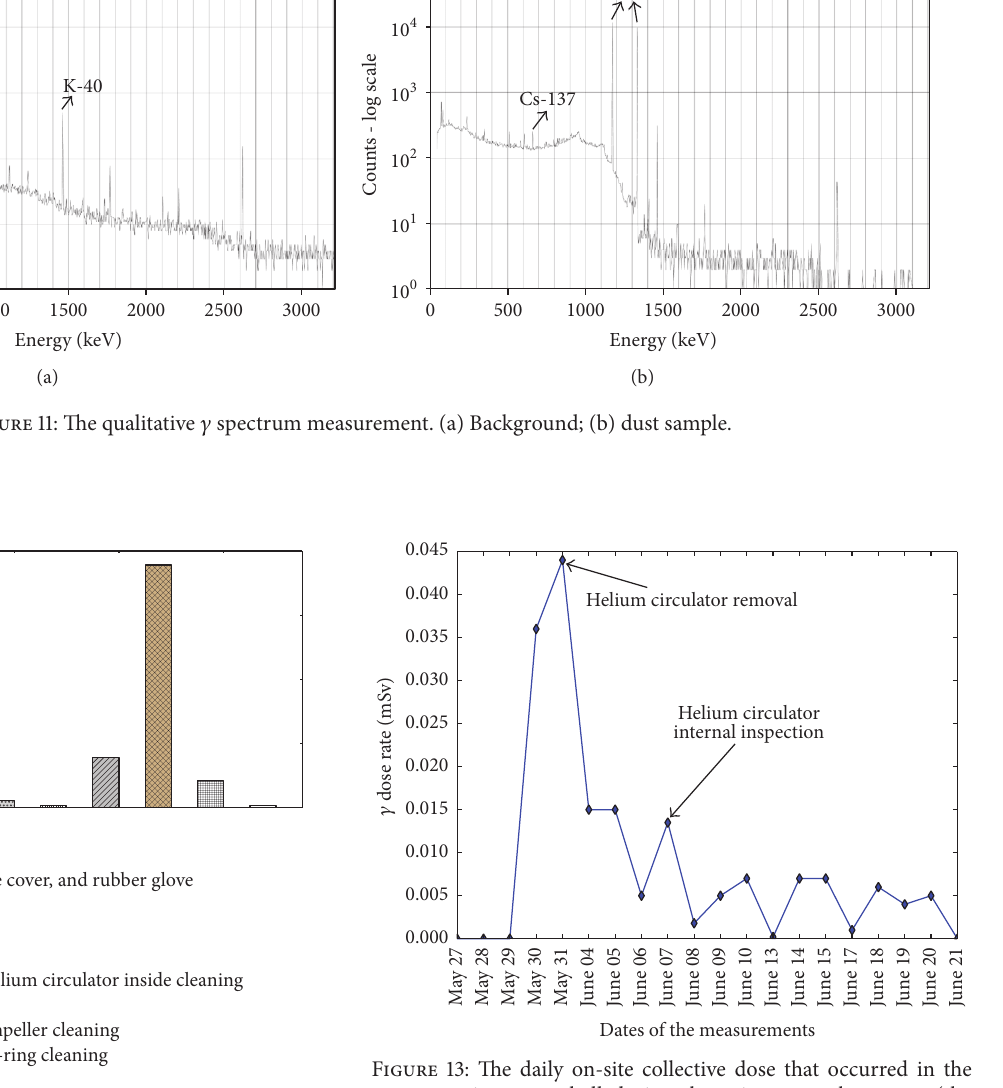
Figure 12: The surface 𝛾 dose rate of radioactive waste generated in the maintenance.